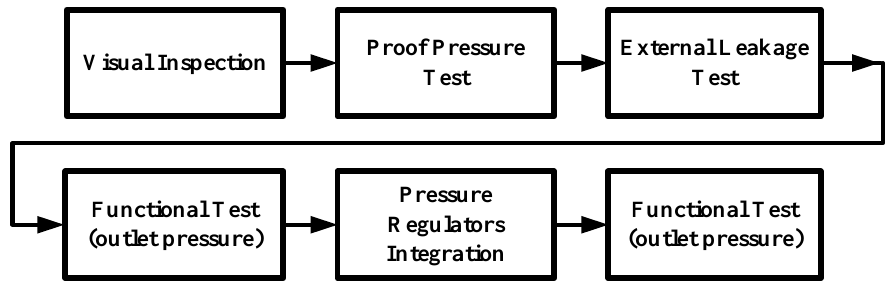
Figure 15. Flow chart showing the sequential acceptance tests performed on each of the pressure regulators produced for the Adelis-SAMSON nano-satellite.